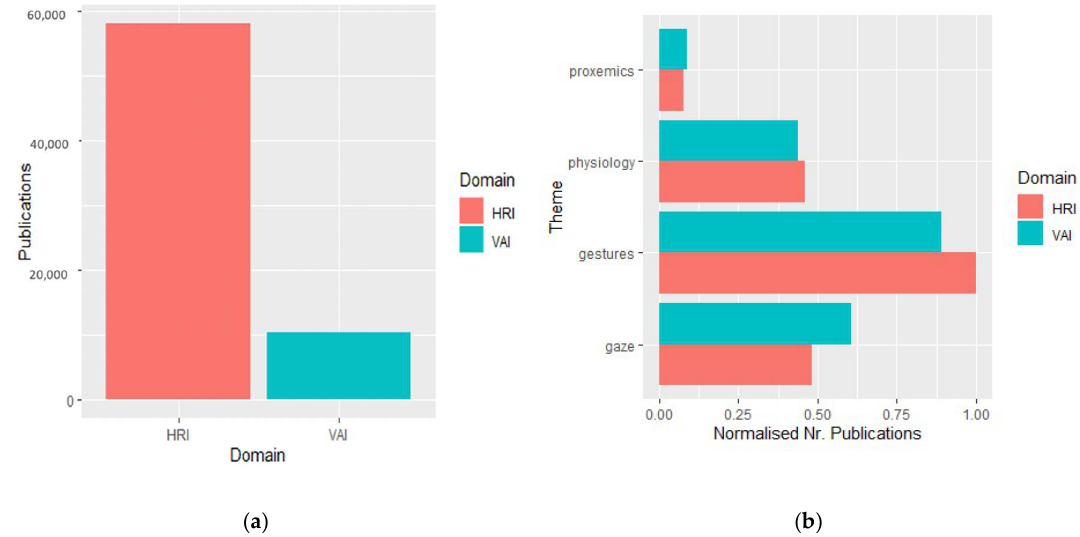
Figure 4. (a) A comparison in the number of publications within HRI and VAI. (b) The number of Google Scholar search results for the use of the terms Gestures, Gaze, Proxemics, and Physiology in the domain of Human-Robot Interaction and Virtual Agent Interaction.